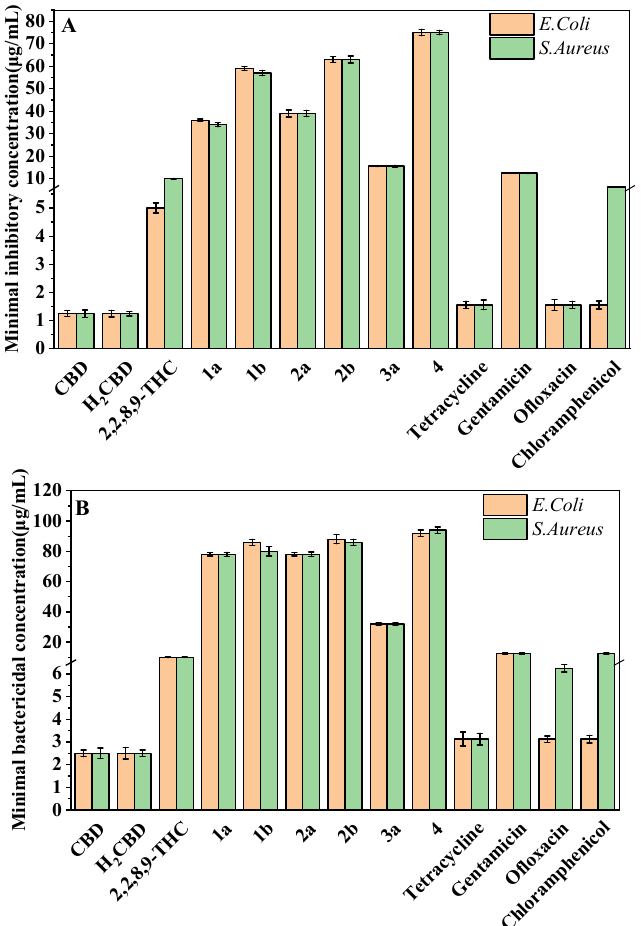
Figure 1. MIC ( A ) and MBC ( B ) of H 2 CBD, CBD, 6,6,8,9-THC, Compounds 1a , 1b , 2a , 2b , and 3a , and the antibiotics against S. aureus and E. coli